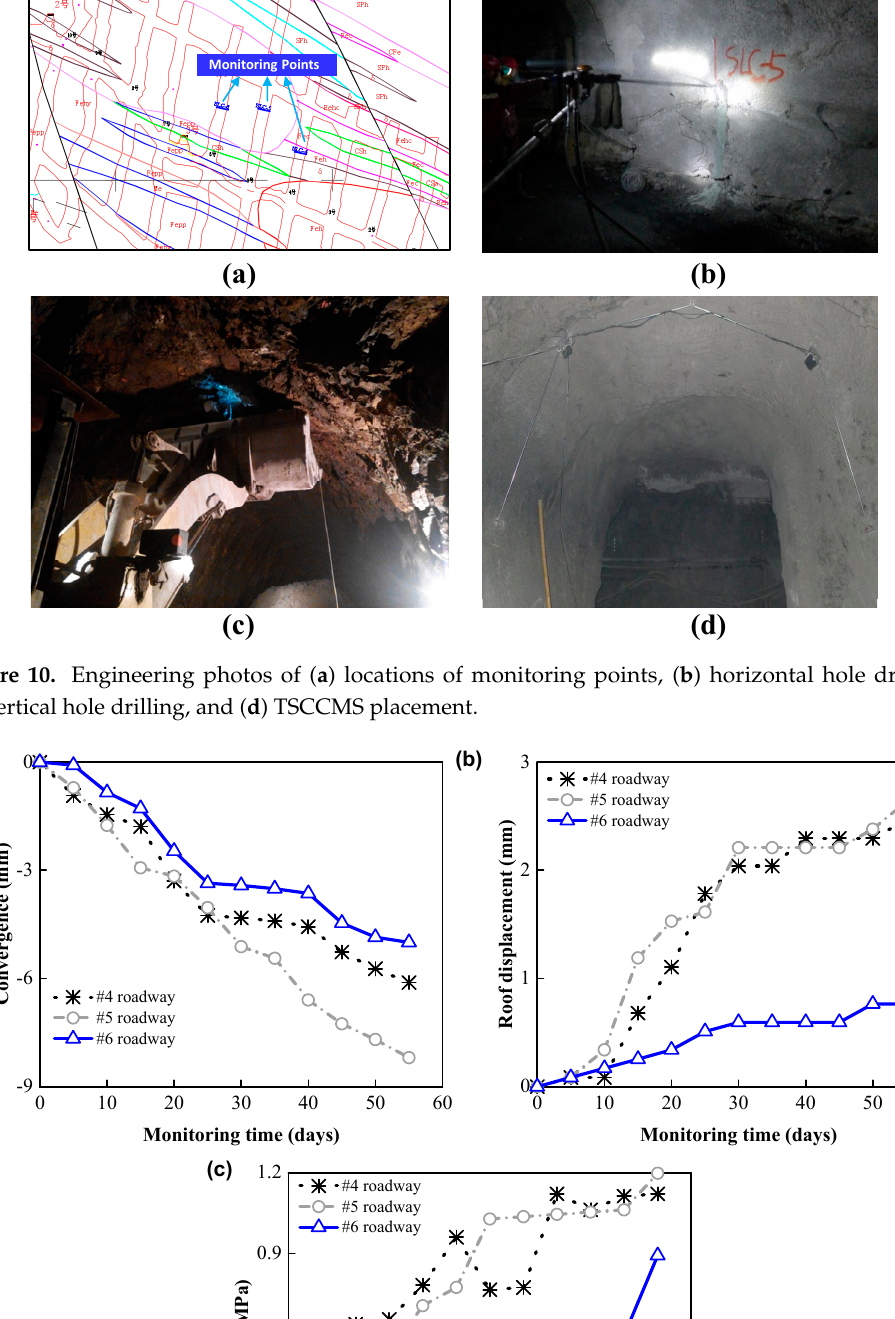
Figure 10. Engineering photos of ( a ) locations of monitoring points, ( b ) horizontal hole drilling, ( c ) vertical hole drilling, and ( d ) TSCCMS placement.